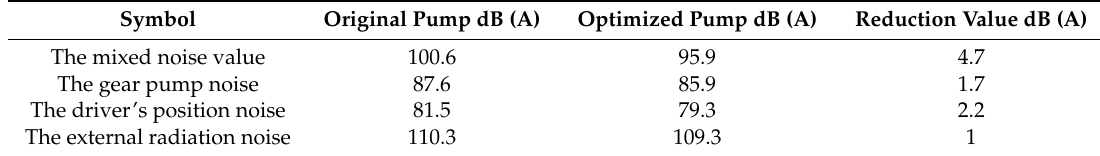
Table 3. Noise values comparison of the gear pump before and after